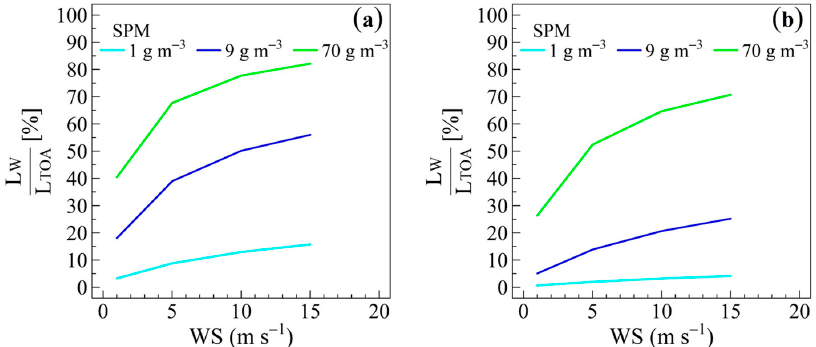
Figure 5. Variation of the ratio L w /L TOA (in %) in the specular direction ( θ v = +30°, φ OSOAA = 0°) as a function of the wind speed WS (in m s -1 ) for various SPM concentrations, namely 1, 9, and 70 g m -3 : ( a ) at 560 nm; ( b ) at 620 nm.